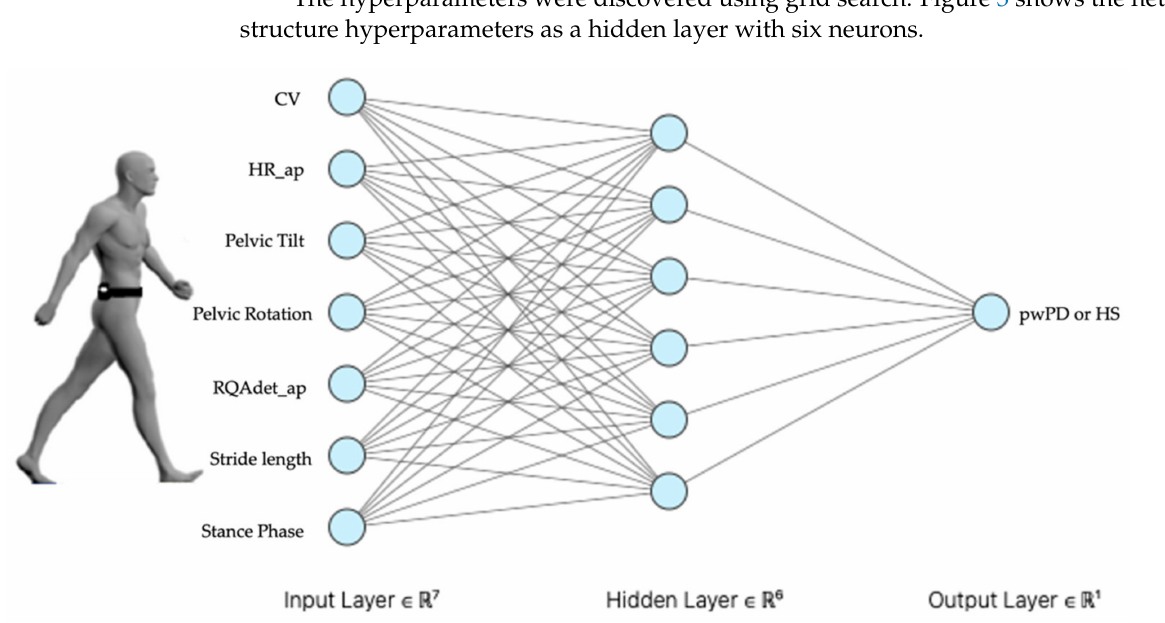
Figure 3. Multilayer perceptron (MLP). Our MLP with seven neurons in input layer, consequently features chosen by dimensionality reduction methods, six neurons in hidden layer, chosen by grid search method, classify our dataset in output layer to predict pathological or healthy subjects’ gait: CV, coefficient of variation of step length; HR ap, harmonic ratio anteroposterior; RQAdet_ap, % determinism in the recurrence quantification analysis anteroposterior; pwPD, people with Parkinson’s disease; HS, healthy